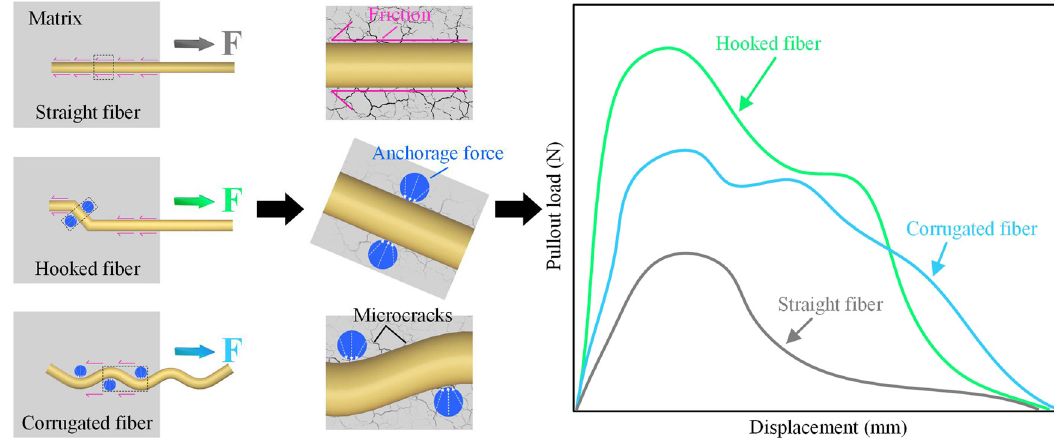
Figure 2: Pullout behavior of steel fi ber with various shapes from SFRCC matrix. For the straight steel fi ber, the friction at interface is the main resistance from fi ber pullout. For the hooked and corrugated steel fi ber, the anchorage force at interface plays a critical role to resist fi ber